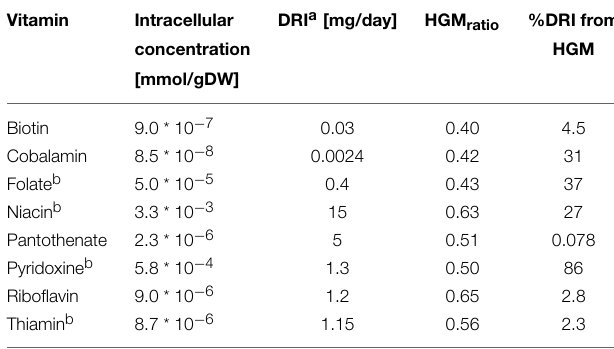
a Dietary reference intakes (Standing Committee on the Scientific Evaluation of Dietary Reference Intakes and Its Panel on Folate, Other B Vitamins, And Choline, 1998). Values averaged for male and female references intakes (ages 19–50). b Atomic mass for dihydrofolic acid, nicotinic acid, pyridoxine 5’-phosphate, and thiamine